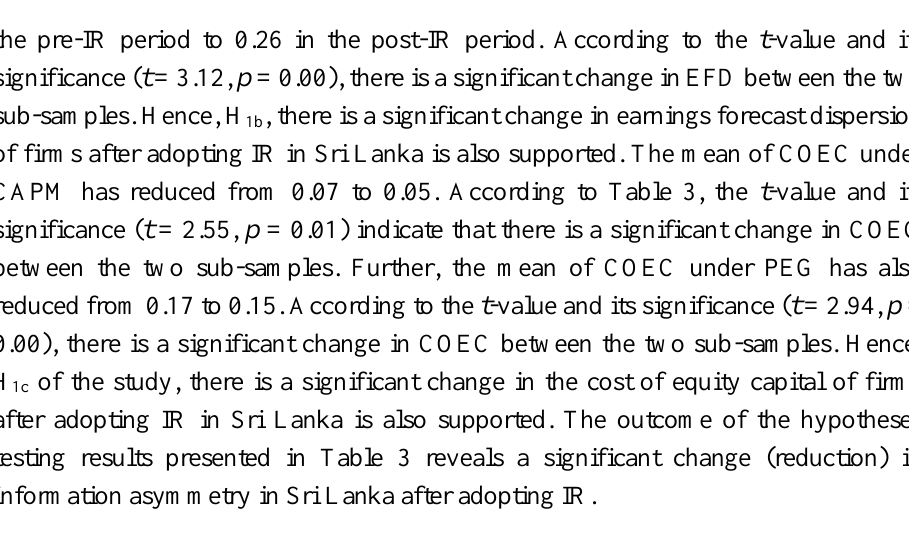
Table 3: Paired Sample t -test for EFE, EFD, and COEC EFE EFD COEC_CAPM COEC_PEG PRE POST PRE POST PRE POST PRE POST Mean 4.61 2.26 0.90 0.26 0.07 0.05 0.17 0.15 Variance 24.56 4.82 1.86 1.16 0.00 0.00 0.00 0.00 t Stat 3.37 3.12 2.55 2.94 P(T<=t) two-tail 0.00** 0.00** 0.01* 0.00** t Critical two-tail 2.01 2.02 1.99